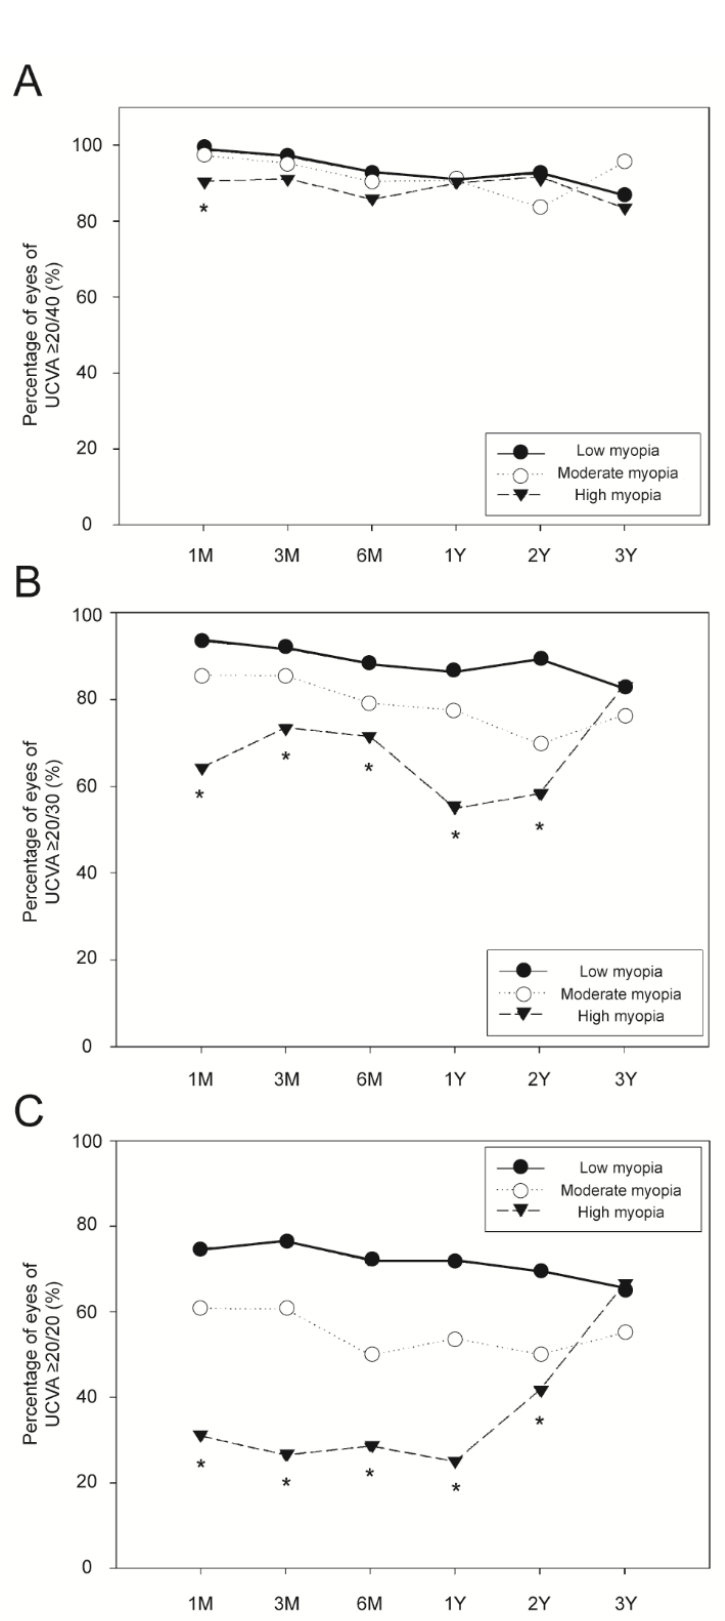
20/40 ( A ), 20/30 ( B ), and 20/20 ( C ) according ≥ ≥ ≥